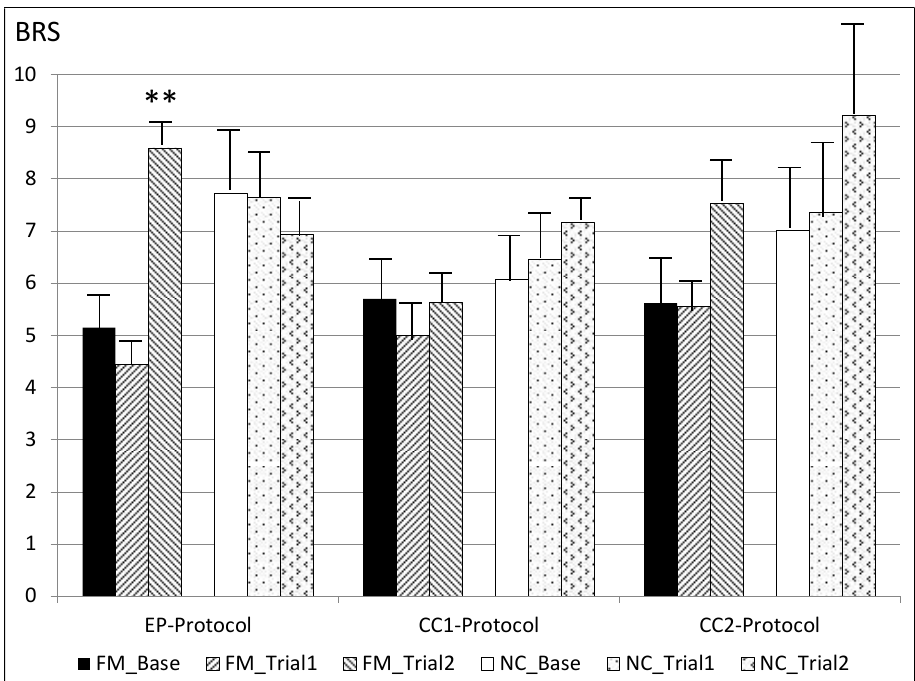
Figure 5. Mean BRS values in EP, CC1, and CC2 protocols, ** p < 0.01 comparing baseline to epoch 1st and to epoch 2nd in FM and NC . Base : baseline. BRS : baroreflex sensitivity. CC1: control condition 1. CC2 : control condition 2. EP: experimental protocol. FM: fibromyalgia patients. NC: normotensive controls.